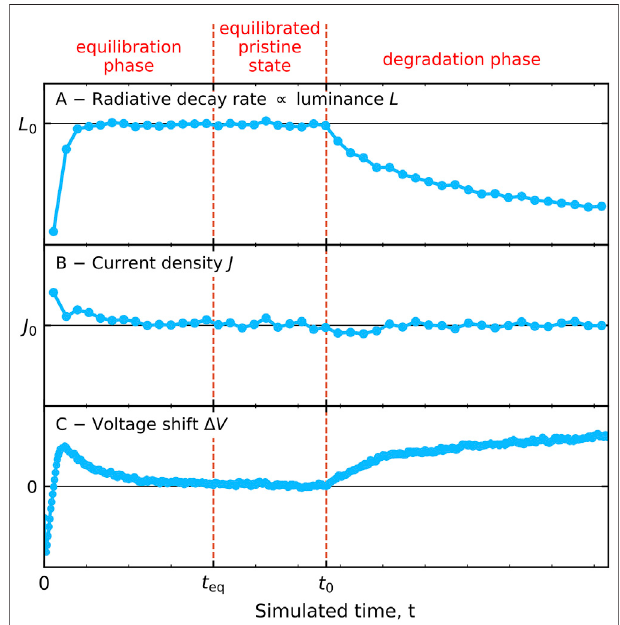
FIGURE 5 | Schematic view of the three phases that can be distinguished when carrying out a KMC degradation simulation using a constant-current mode. Degradation is switched off during the equilibration phase, where the device is brought to a dynamic equilibrium condition, and during a phase that starts at a time t eq within which the device is in the equilibrated pristine state and within which the device performance is initially determined. The degradation phase begins at a time t 0 at which the degradation processes are enabled. (A) Radiative decay rate R ( t ), which is proportional to the luminance L ( t ). (B) Actual current density J ( t ), which is kept close to the desired current density J 0 by a feedback loop that determines the applied voltage. (C) Shift of the applied voltage Δ V ( t ) with respect to the pristine state